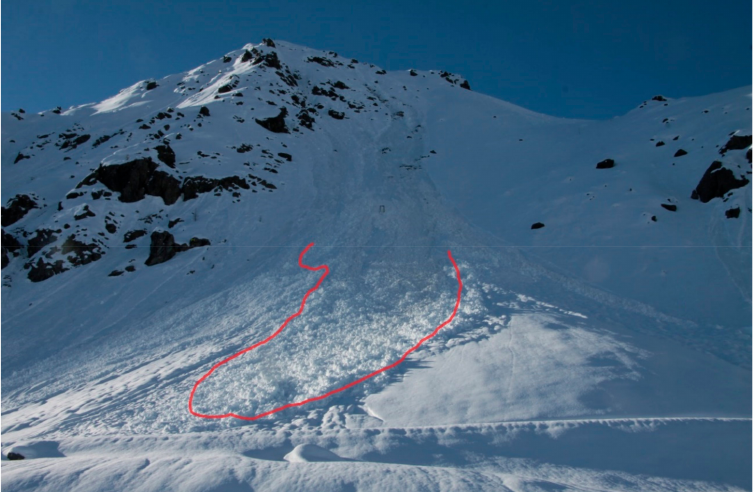
Figure 12. Overview of the events observed on 1 May 2014. Among the avalanches released in the period 27–30 April, the red line highlights the deposit of the event on 30 April 2014. Photo M.